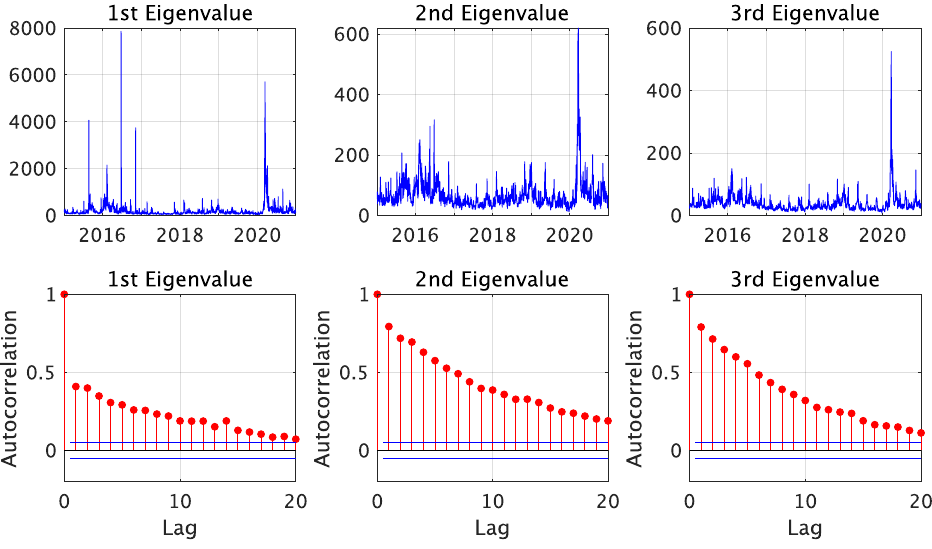
Figure 2. Eigenvalues estimated by POET and sample autocorrelation functions. Table 2. The eigenvalues estimated by POET and SPOET of 200 dimensional